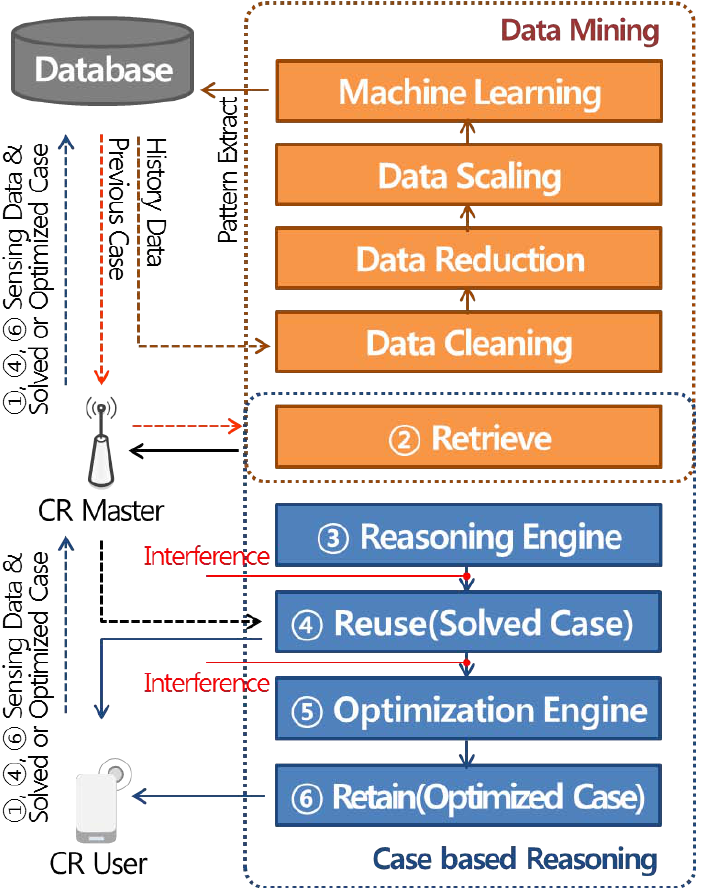
Figure 1. Intelligent dynamic real-time spectrum resource management structure based on data mining and case-based